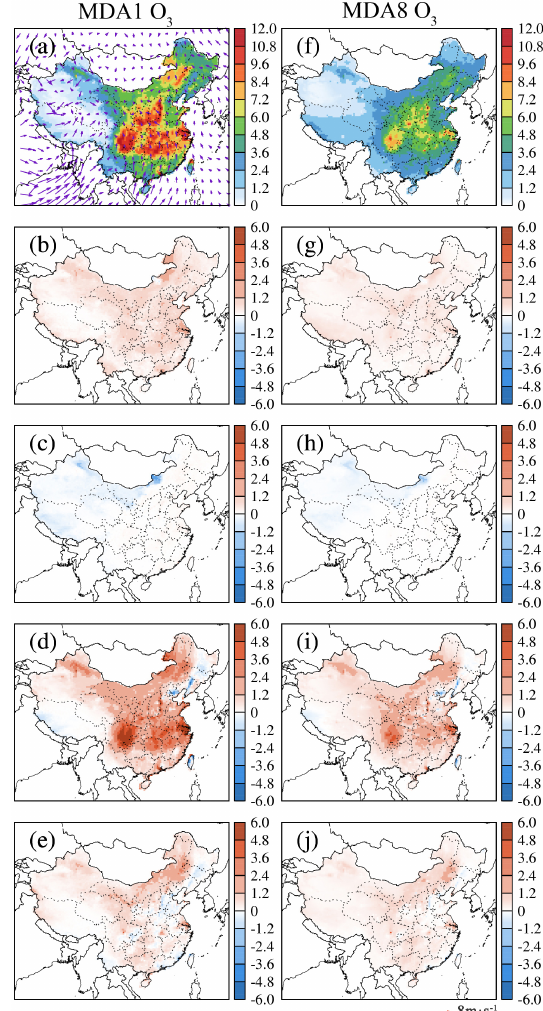
Figure 5. Spatial distributions of MDA1 O 3 and MDA8 O 3 from biogenic sources in the different cases in summer. (a, f) C1, (b, g) C1–C2, (c, h) C1–C3, (d, i) C1–C4, and (e, j) C1–C5. Unit is parts per